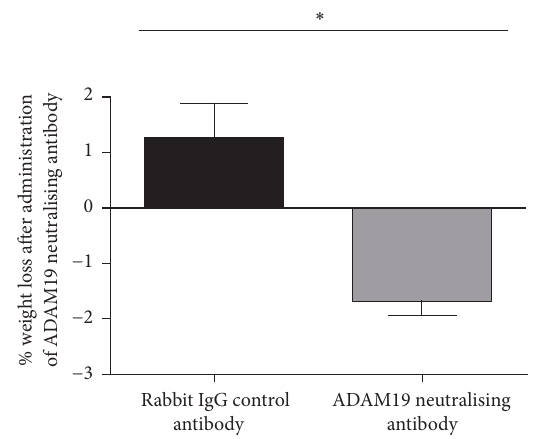
Figure 5: Elevated weight loss after administration of ADAM19 neutralising antibody. Mice which were administered ADAM19 neutralising antibody lost a significant amount of weight when compared with mice administered the rabbit IgG control antibody. Mean + SEM; ∗ 𝑝 = 0.0126 ; 𝑛 = 3 mice/group.